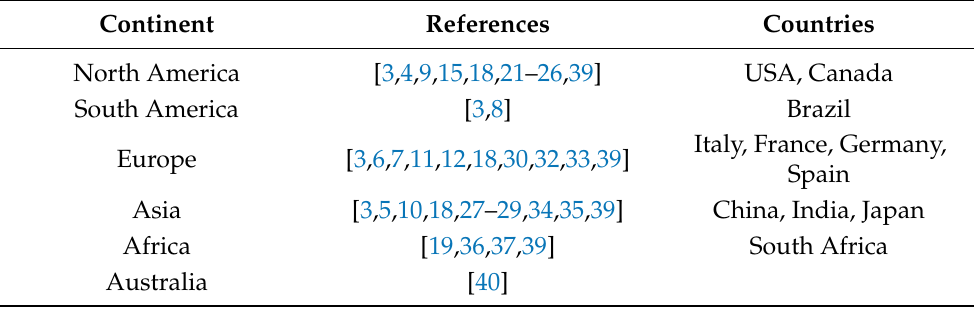
Table 2. Works sorted by continent and country.